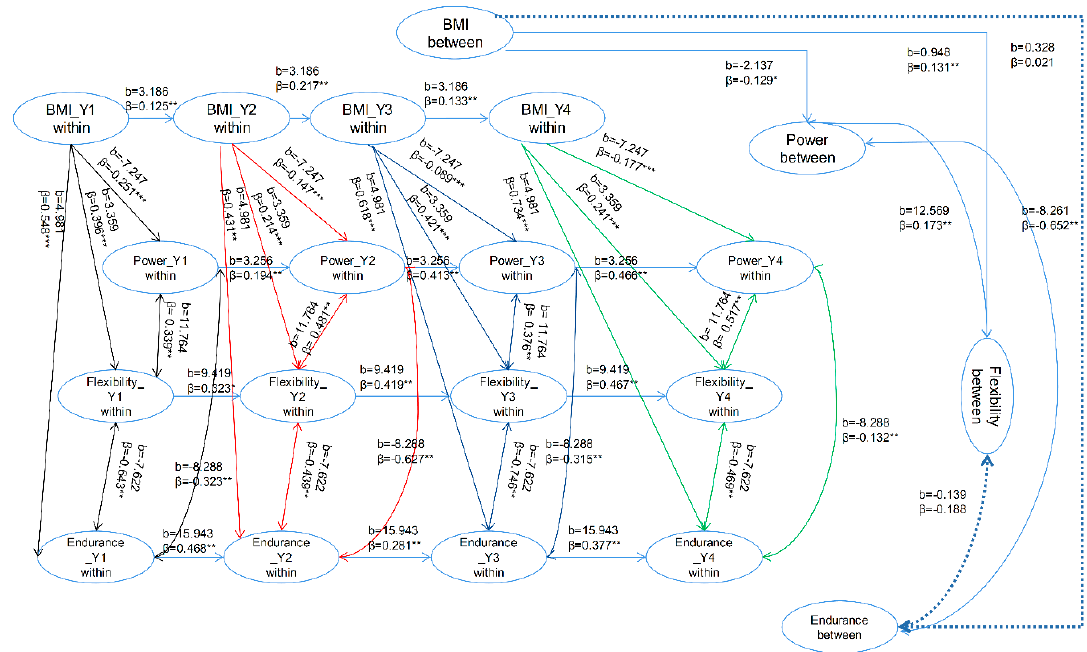
Figure 2. Estimated random intercept panel model of the female samples: simplified and represented above. The dotted line indicates the statistically insignificant coefficient. * p < 0.05; ** p <0.01, *** p <0.001.